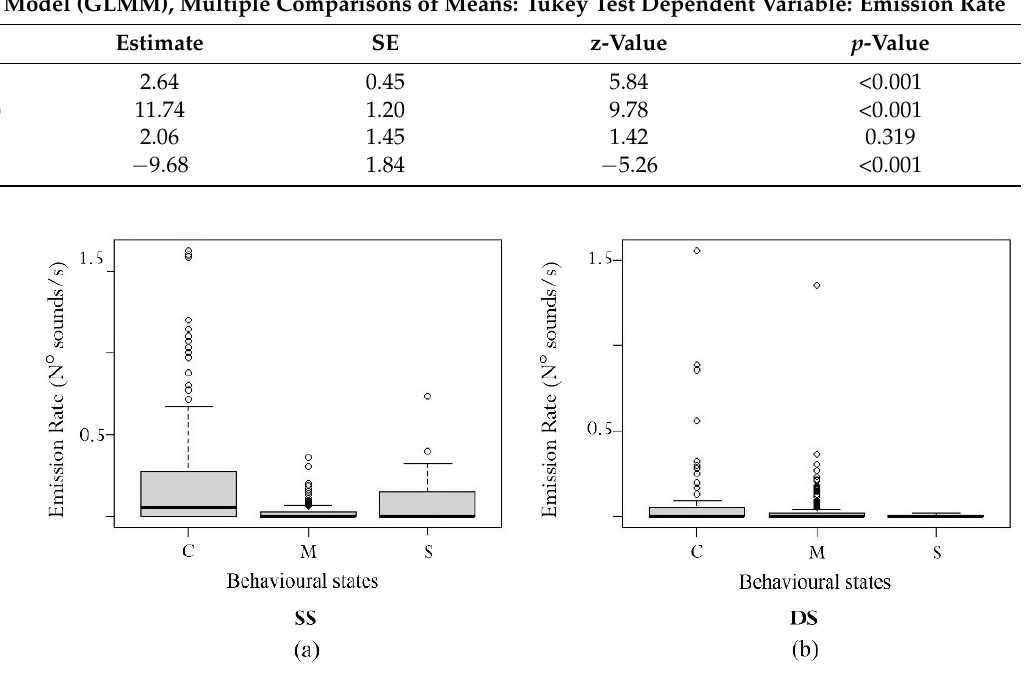
Figure 5. Box plots of the signal emission rates during Contact (C), Moving (M), and Still (S) behaviours considering ( a ) SS and ( b ) DS experimental settings. Table 2. Result of Generalized Linear Mixed Model on emission rate among Contact (C), Moving (M), and Still (S) behavioural states including the trials as the random effect.